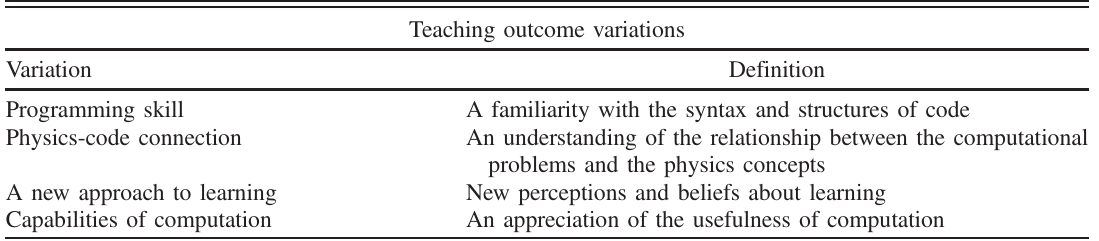
TABLE VI. Variations within the teaching outcome theme, describing learning assistants ’ goals for their students.